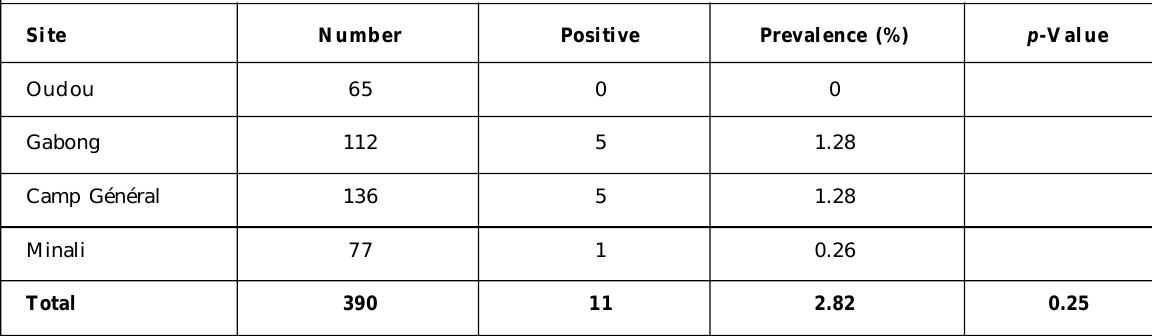
Table 1: Prevalence of bovine trypanosomiasis with respect to sites Site